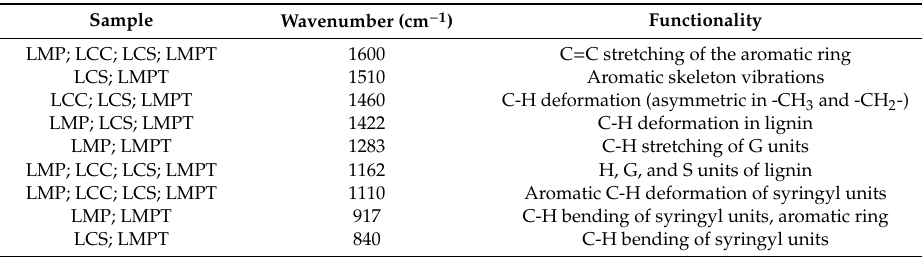
Table 1. Peaks Observed in FTIR